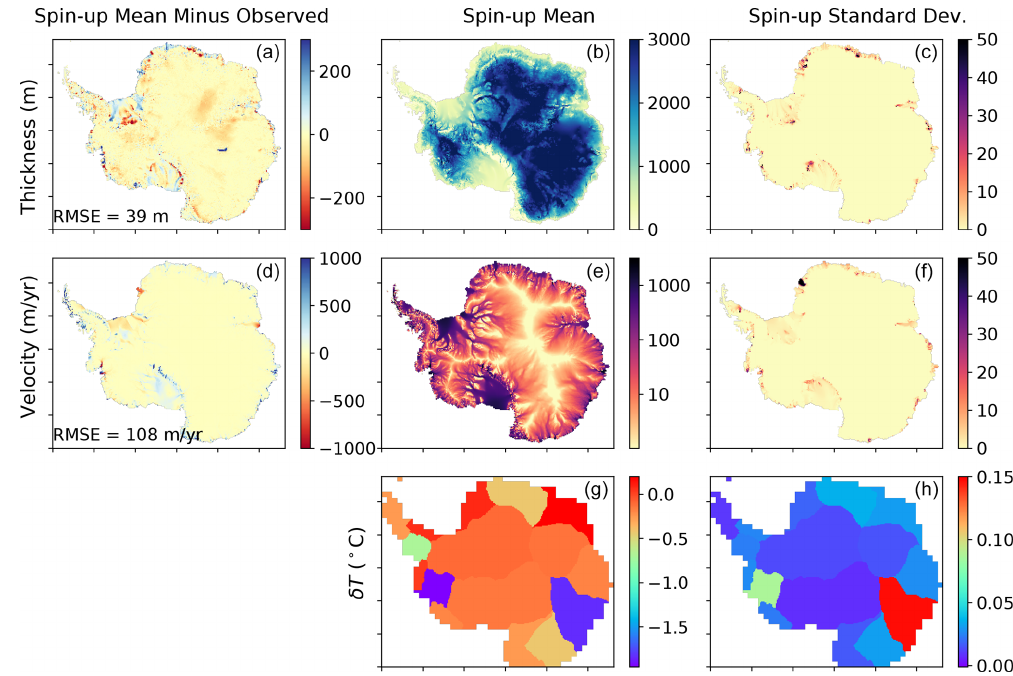
Figure 5. End-of-spin-up statistics: thickness (a, b, c) , surface velocity (d, e, f) , and δT values (g, h) . Columns show the end-of-spin-up mean minus observed values (a, d) , spin-up mean (b, e, g) , and standard deviation (SD) (c, f, h) . Spin-up mean and SD are computed across all 25 p and γ 0 ensemble members. Observed thickness is from the BedMachine Antarctica V2 (Morlighem et al., 2020), and observed velocities are from Mouginot et al. (2014).